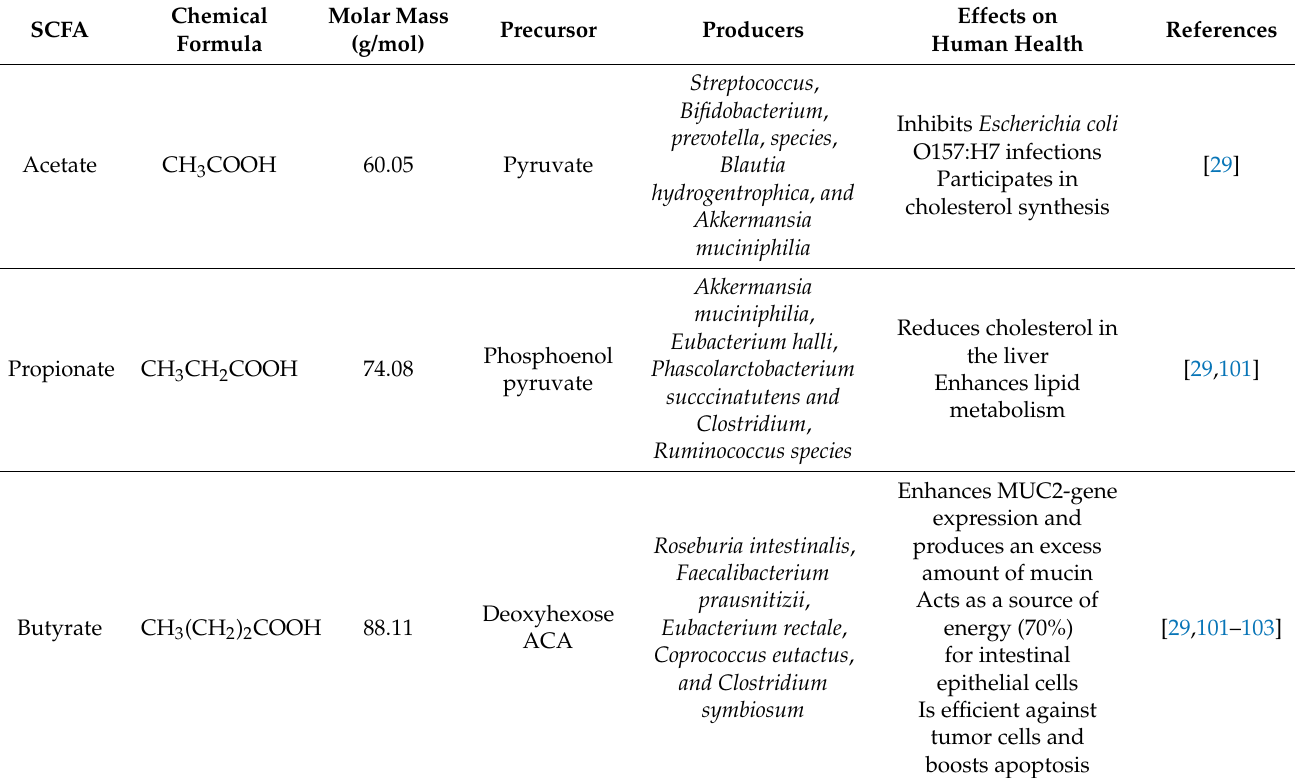
Table 1. Important health benefits of short-chain fatty acids in modulating gut